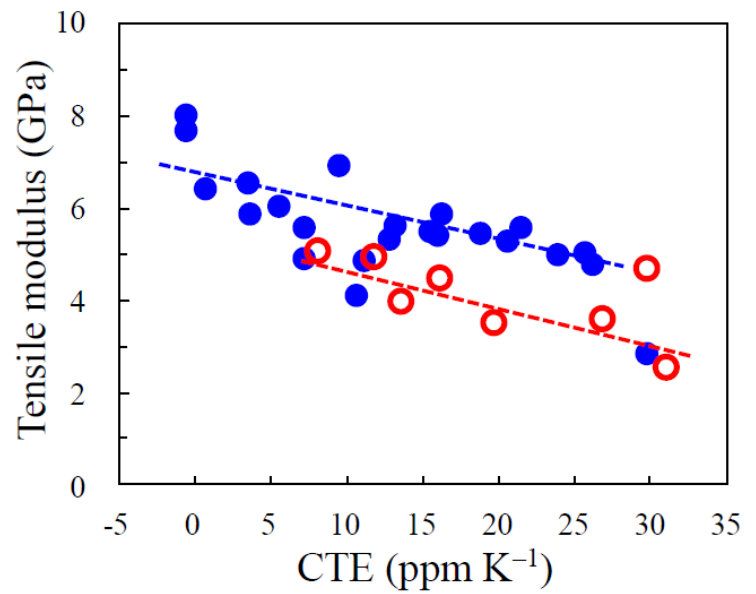
Figure 11. Correlation of the tensile modulus and CTE for the PEsIs developed in this work: ( • ) homo PEsIs and ( ○ ) the related copolymers.